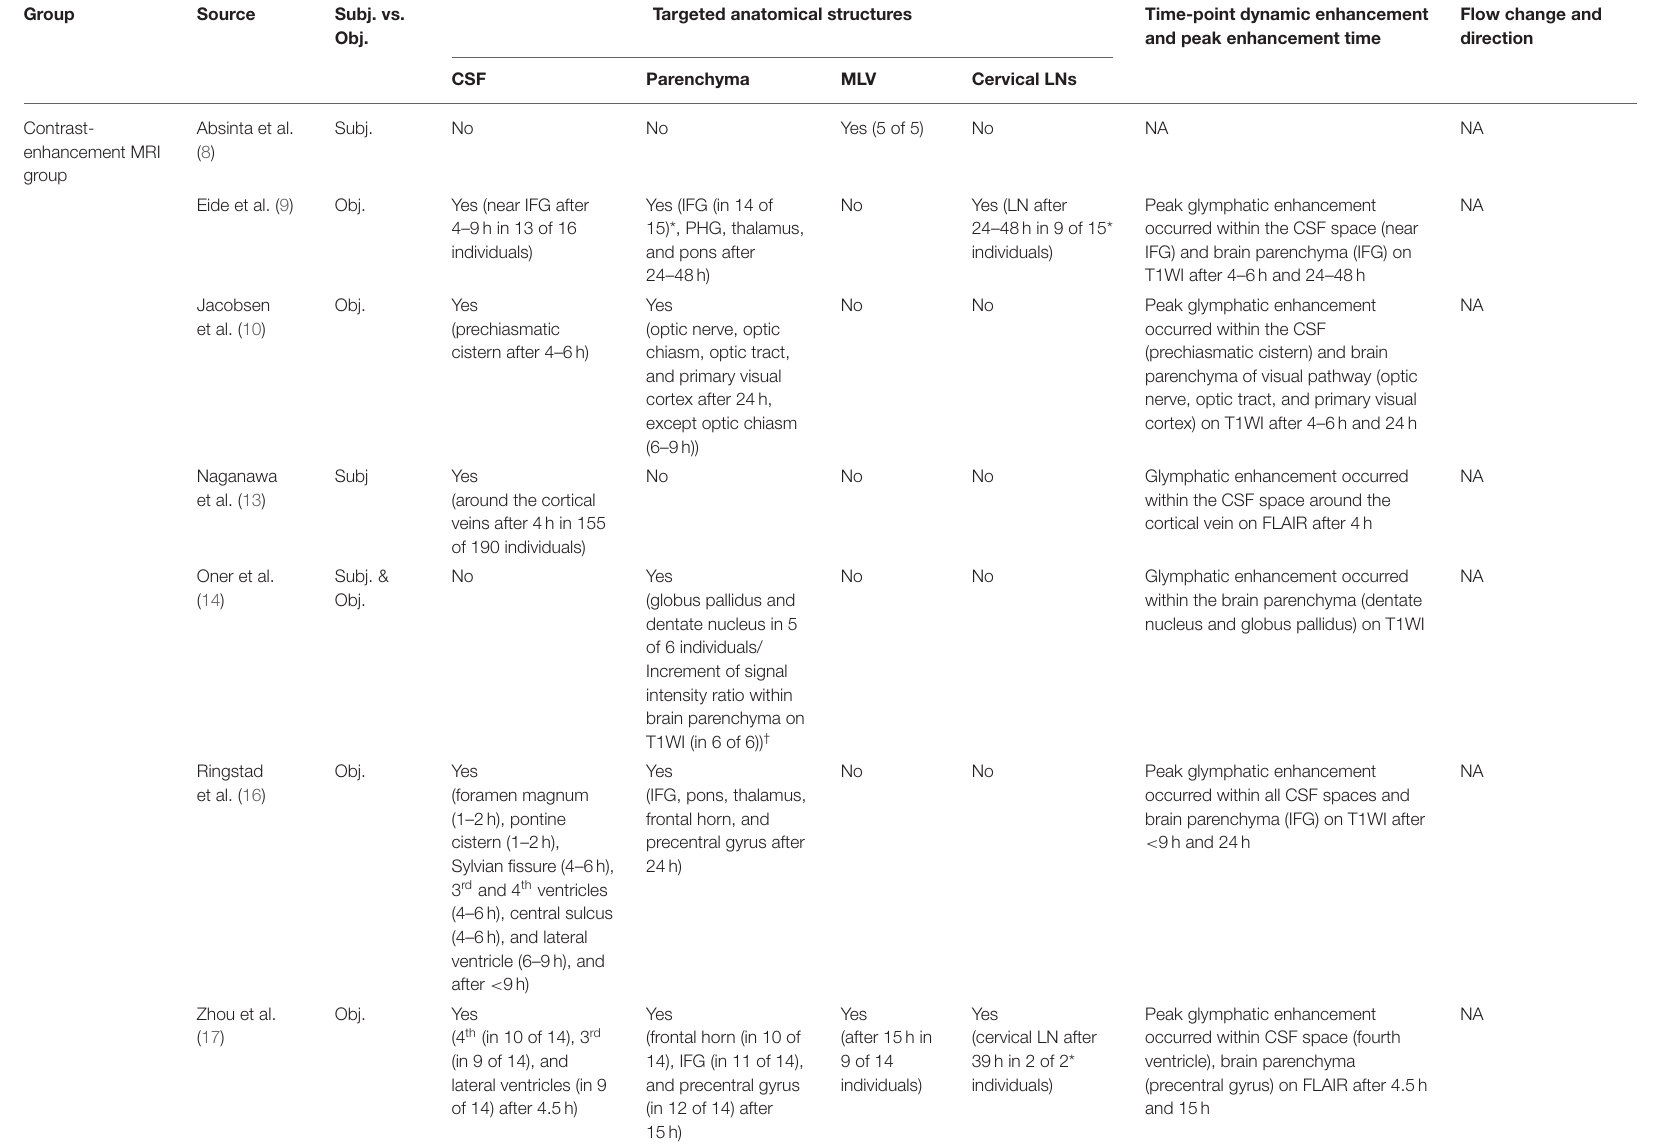
TABLE 3 | Analytic method used in the glymphatic assessment of each sequence.